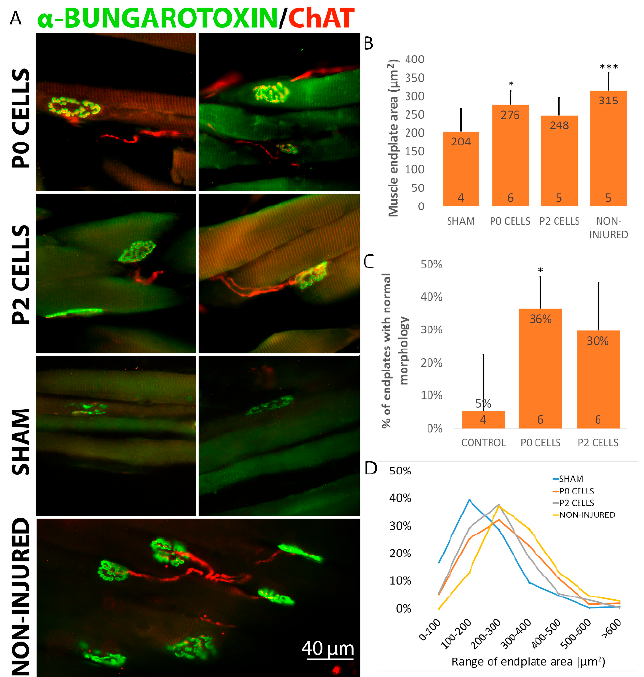
Figure 6. Cell graft derived axons made new connections with muscle endplates and helped to retain their size and morphology. ( A ) Biceps brachii muscle longitudinal sections highlighting neuromuscular junctions, stained with α -bungarotoxin for nicotinic acetylcholine receptors expressed on muscle endplates, and anti-ChAT as an indicator of motoneuron axons. Numerous connections between axons and muscle endplates can be seen on the slides from cell-grated animals, similar to non-injured muscle. In contrast, no axons can be seen making connections with endplates in sham animals and the endplates show shrunken and degenerated morphology. Statistical difference is shown versus Sham; ( B ) Animals from the cell-grafted groups had significantly larger muscle endplates compared to the sham group; ( C ) Numerous endplates in cell-grafted animals had endplates with normal pretzel-like morphology. Data is expressed as mean + SEM. * p < 0.05, *** p < 0.001. The number of animals in each group is shown inside the bar base; ( D ) Distribution of the muscle endplate areas shows that muscles from sham animals have more endplates with the size of 0–100 and 101–200 µm 2 compared to the cell-grafted and non-injured groups where more endplates have size around 201–300 and 300–400 µm 2 . All these figures and graphs are shown for 12 weeks timepoint. Statistically significant differences were seen between frequency distributions of different groups ( p < 0.0001 for all different groups vs. Sham, p < 0.0001 for all groups vs. Non-injured, p < 0.01 P0 cells vs. P2 cells). All these figures and graphs are shown for 12 weeks timepoint.